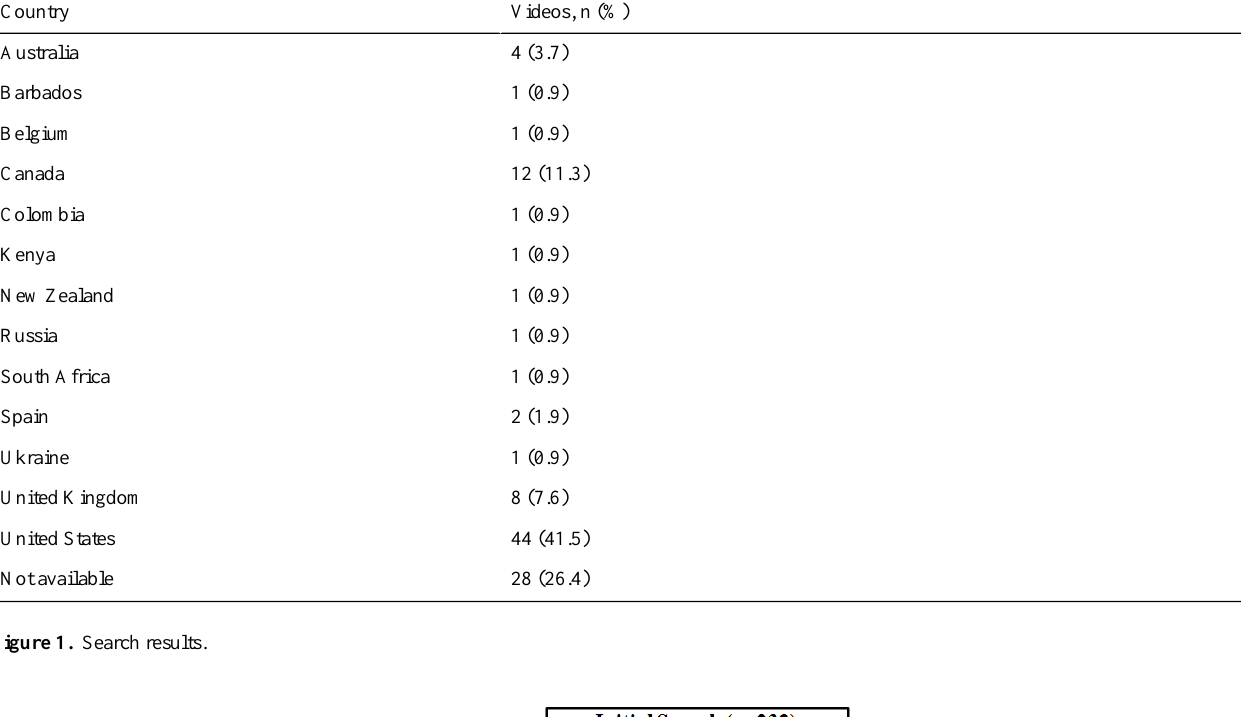
Table 2. Location of origin for videos (N=106).